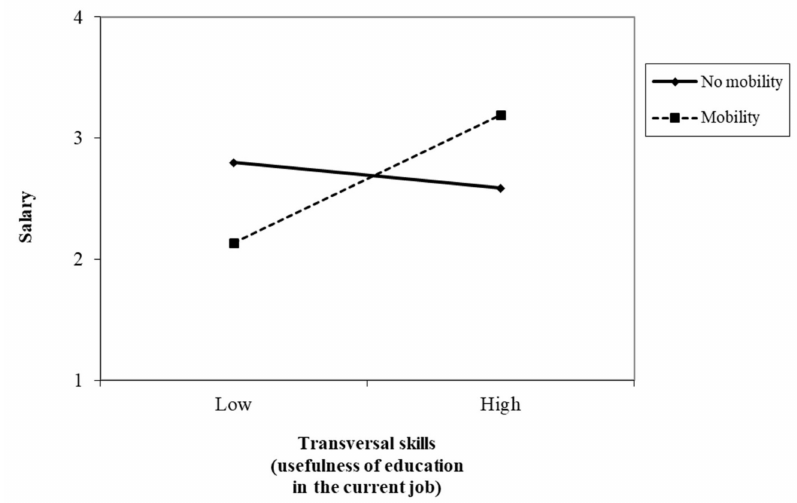
Figure 4. Interaction between transversal skills (usefulness of education in the current job) and mobility in predicting salary.